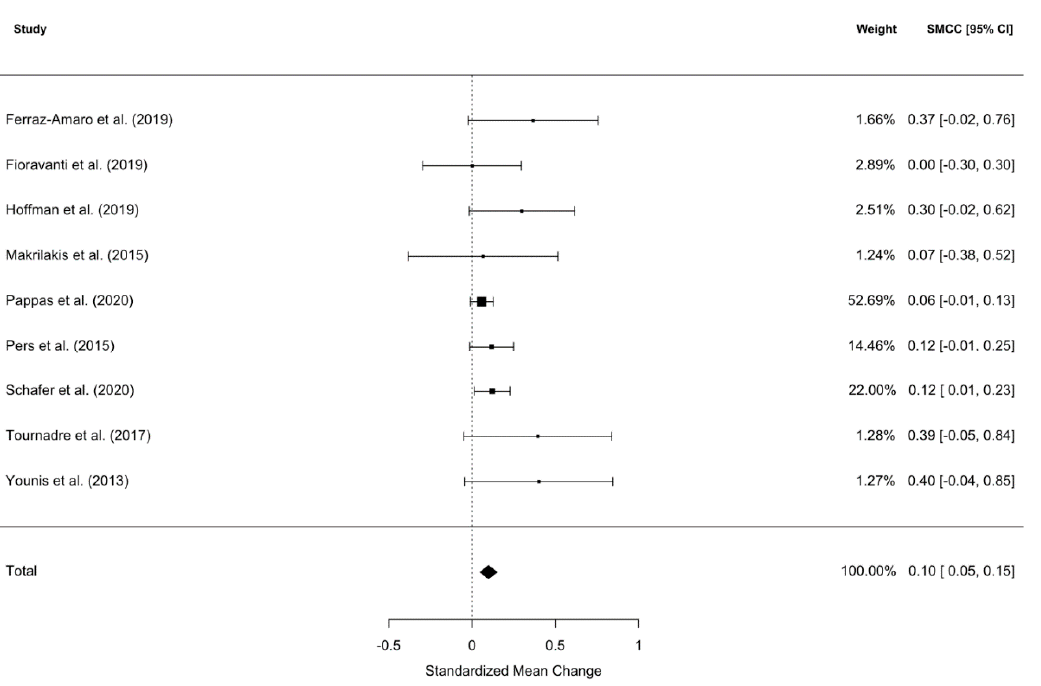
Figure 2. Forest plot of standardized mean change in body mass index (BMI) from nine datasets (n = 1537). Zero indicates no effect, whereas points to the right indicate an increase in weight when comparing values at baseline and after treatment with an IL-6 signaling pathway inhibitor.